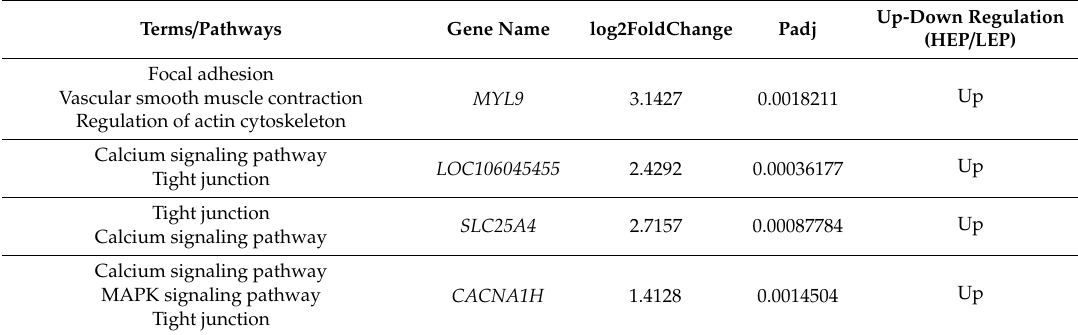
Figure 8. KEGG Analyses of the pituitary DEGs.